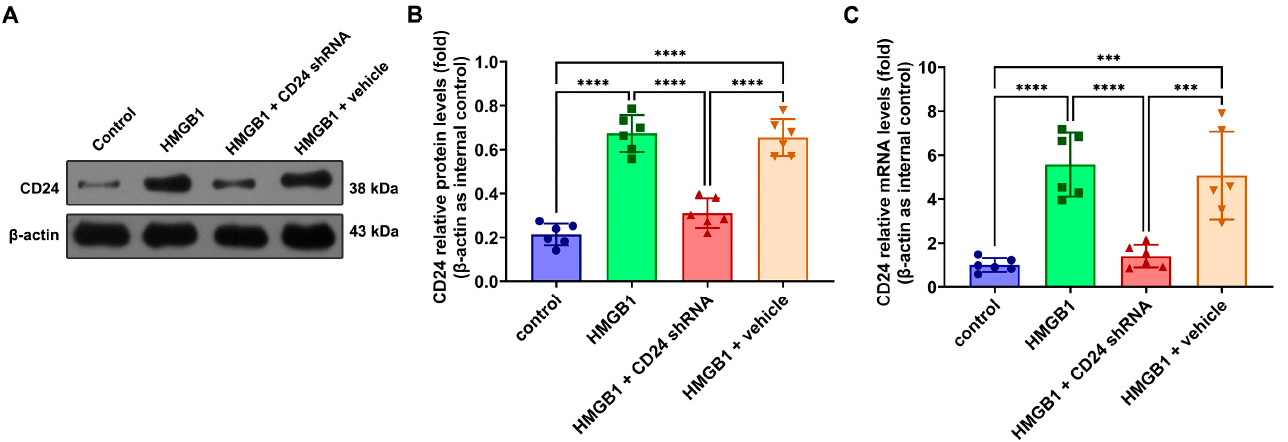
Figure 2. Expression of CD24 decreased after shRNA interference. ( A ) Protein expression of CD24 in astrocytes using β -actin as loading control; ( B ) Graphic representations of the ratios of CD24/ β - actin protein; ( C ) mRNA expression of CD24 in astrocytes using β -actin as loading control. Bars represent the mean ± SD ( n = 6, each group). *** p < 0.001, **** p < 0.0001 vs. control or indicated groups. Statistical comparison was conducted using one-way ANOVA; p < 0.05 was considered statistically significant.